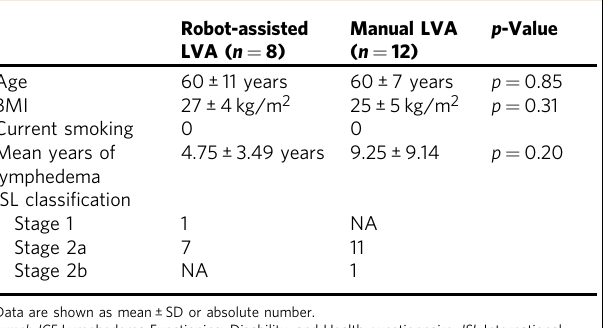
Table 1 Patient characteristics.